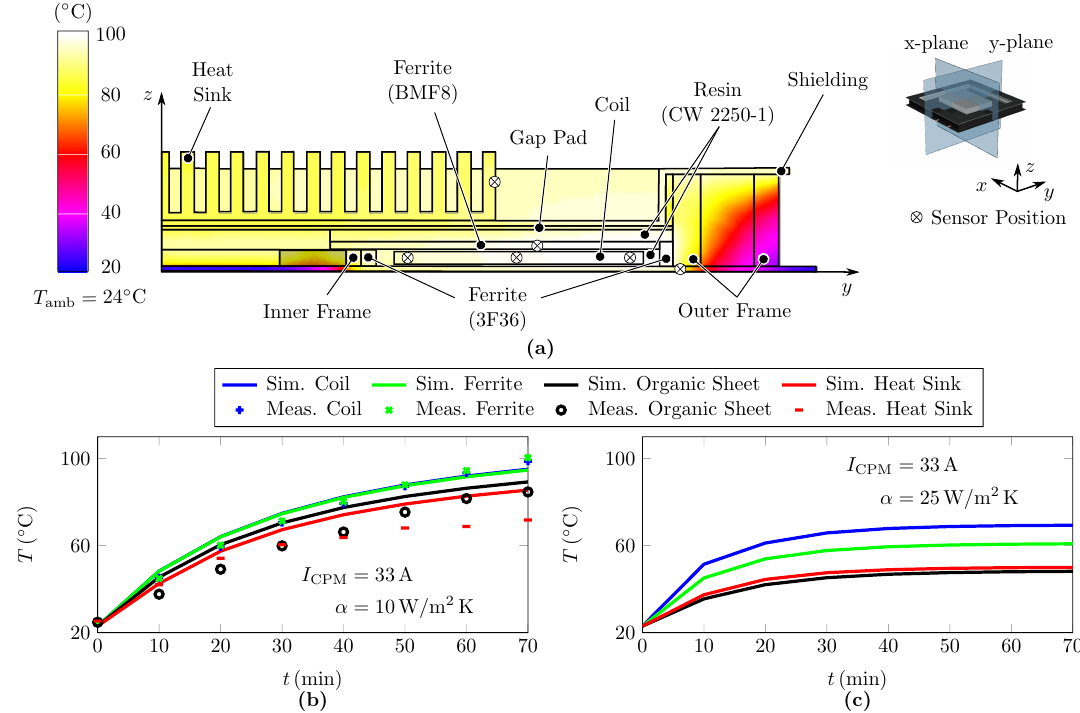
Figure 14. ( a ) Results of the thermal FE analysis of space–frame concept on component level at t = 70min, ( b ) comparision of heating results of FE analysis and component level testing with natural convection ( α = 10W/m 2 K), ( c ) FE analysis with forced convection ( α = 25W/m 2